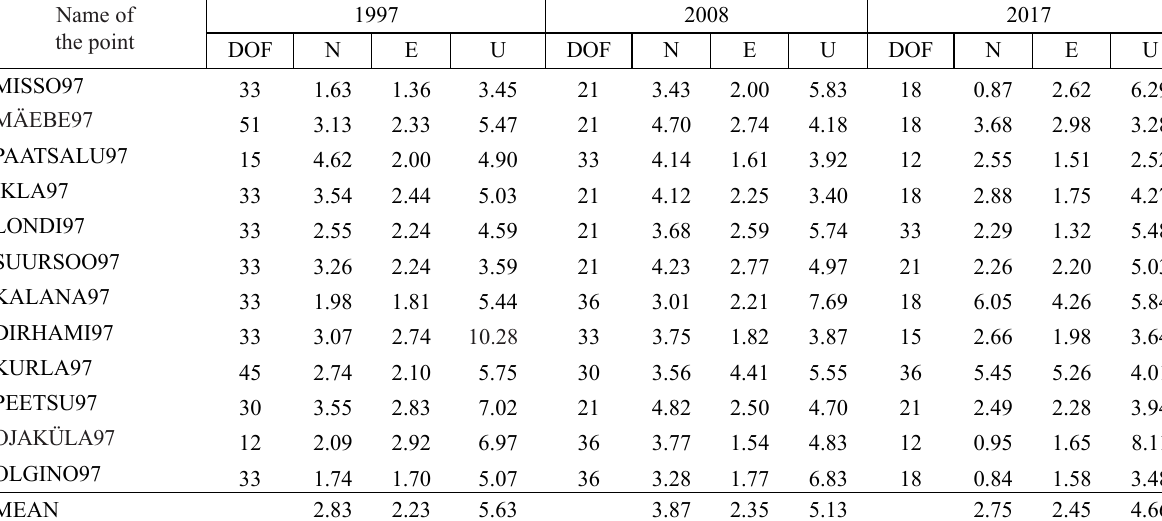
Table 3. Repeatability (in mm) in terms of the standard deviation of the North (N), East (E) and Up (U) coordinates and degree of freedom (DOF) from different measurement sessions of GOA PPP processing of the GRN points